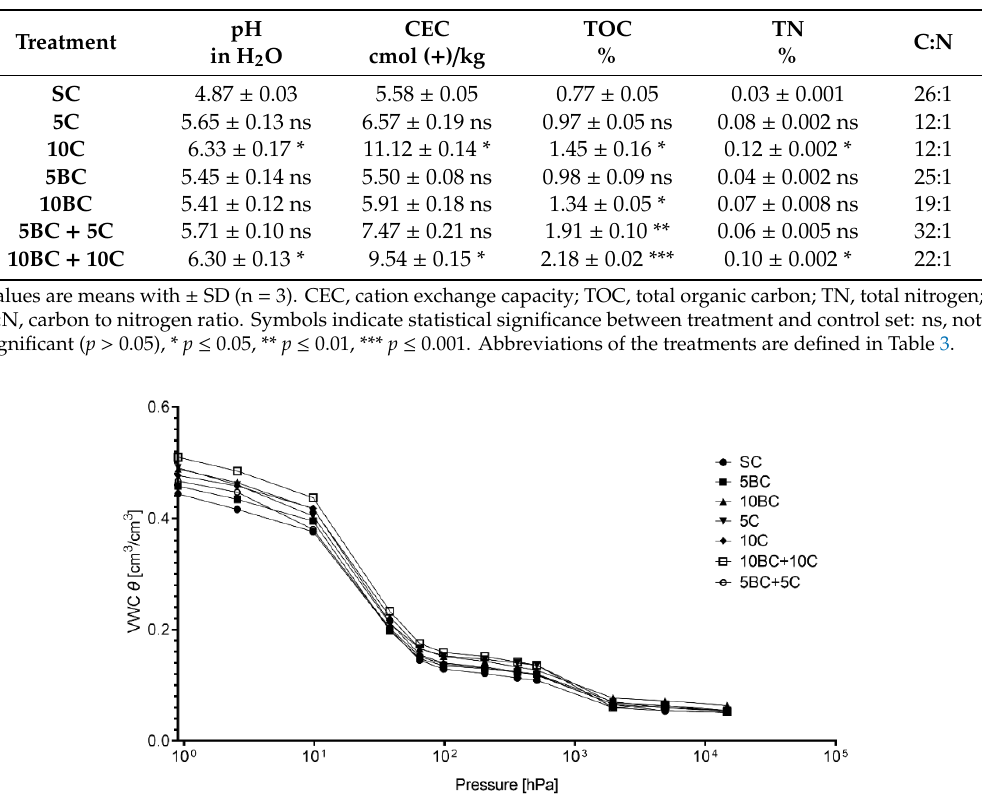
Table 4. E ff ect of biochar and compost on soil chemical properties after eight weeks of incubation.